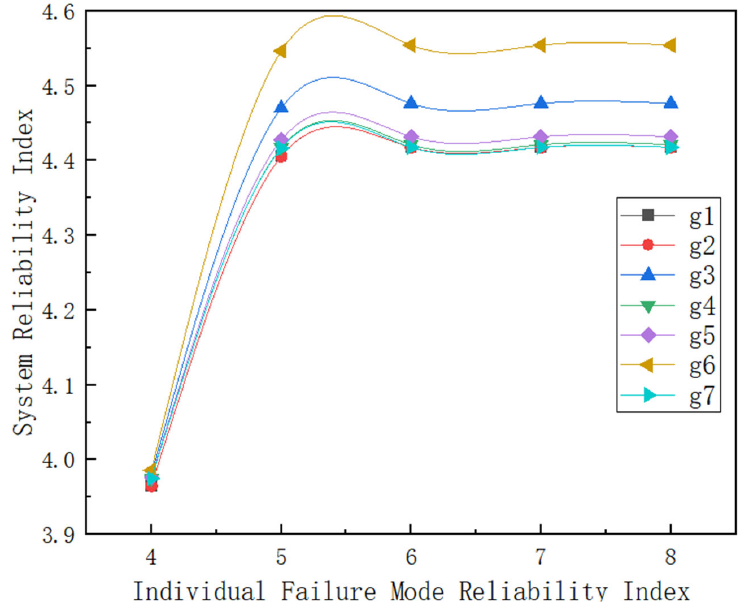
Figure 2. Variation diagram of system reliability index with single failure mode reliability index when the variation range of reliability index is 4~8.